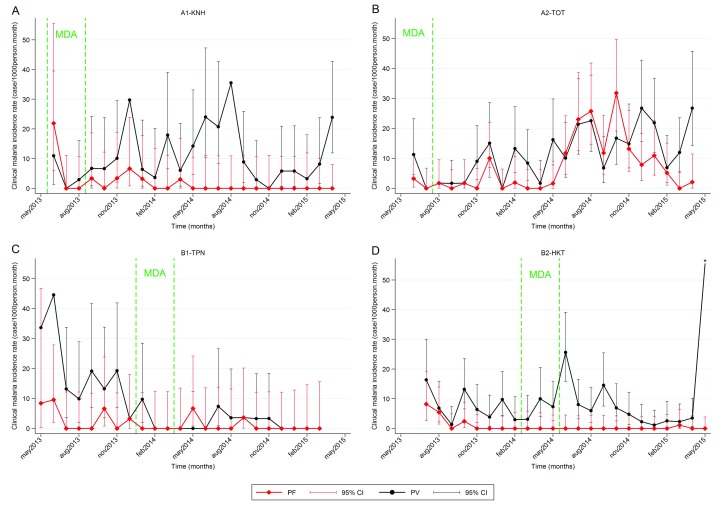
Changes in the incidence of
P. falciparum and
P. vivax clinical cases.Clinical falciparum malaria cases persisted up to 9 months in villages achieving stable <1%
P. falciparum prevalence after MDA (A1, B1 and B2), before zero incidence was achieved. In village A2, where the intervention with MDA was not considered successful, a significant increase in incidence was observed during the rainy and cold seasons from July 2014 to January 2015.*
P. vivax incidence rate in B2-HKT for June 2015 was 100 cases/1000 person-month (95%CI=81-122).